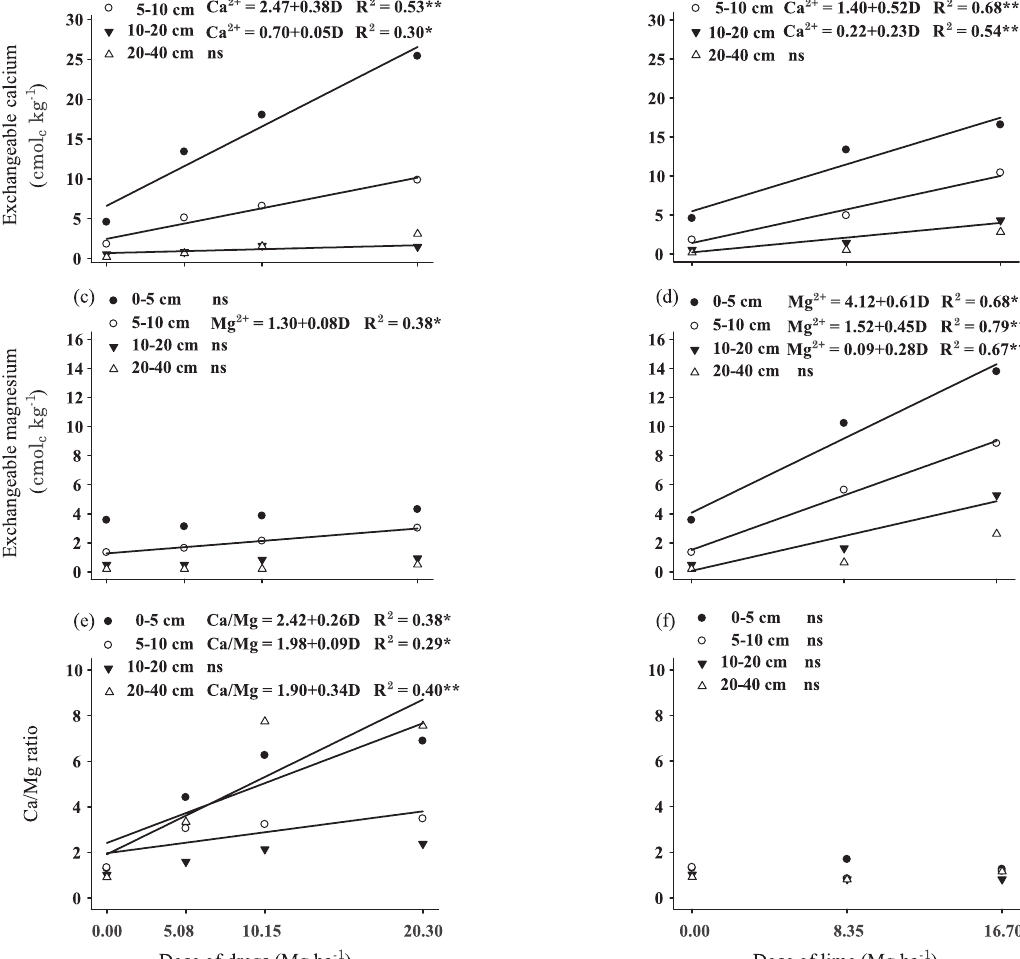
figure 2. exchangeable calcium and magnesium (ca 2+ , mg 2+ ) and ca/mg ratio in the layers of a humic cambisol amended with doses (d) of dregs (a, c, e) and lime (b, d, f) applied to the soil surface in 2004/2006. Bocaina do sul, sc, 2010. (*, **, *** and ns: significant at 5, 1, 0.1 % and not significant,